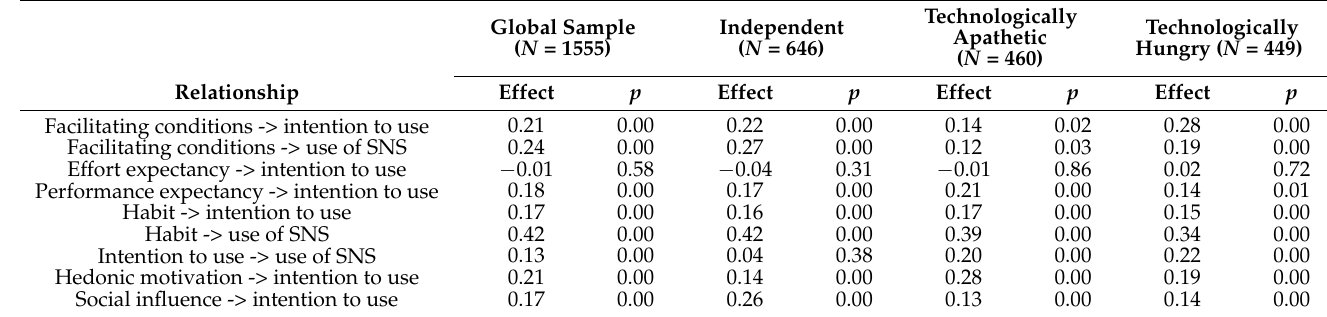
Table 5. Structural model